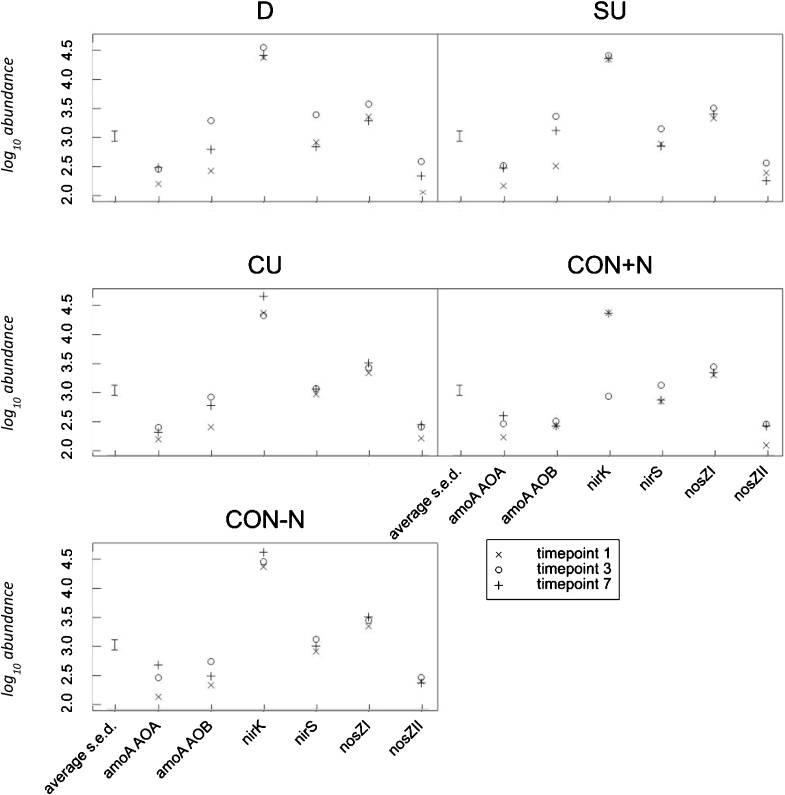
Total abundance of the amoA AOB, amoA AOA, nirK, nirS, nosZI and nosZII genes for all farmlets within treatments. Time point 1 = 4 days before treatment application; time point 3 = 24 days after treatment application; time point 7 = 126 days after treatment application. Values are expressed as log gene copy number × g−1 dry soil. PP = permanent pasture; WC = white clover/high sugar grass mixed sward; HS = high sugar grass monoculture. D = dung; SU = synthetic urine; CU = cattle urine; CON + N = control with synthetic nitrogen fertiliser; CON-N = control with no amendments.